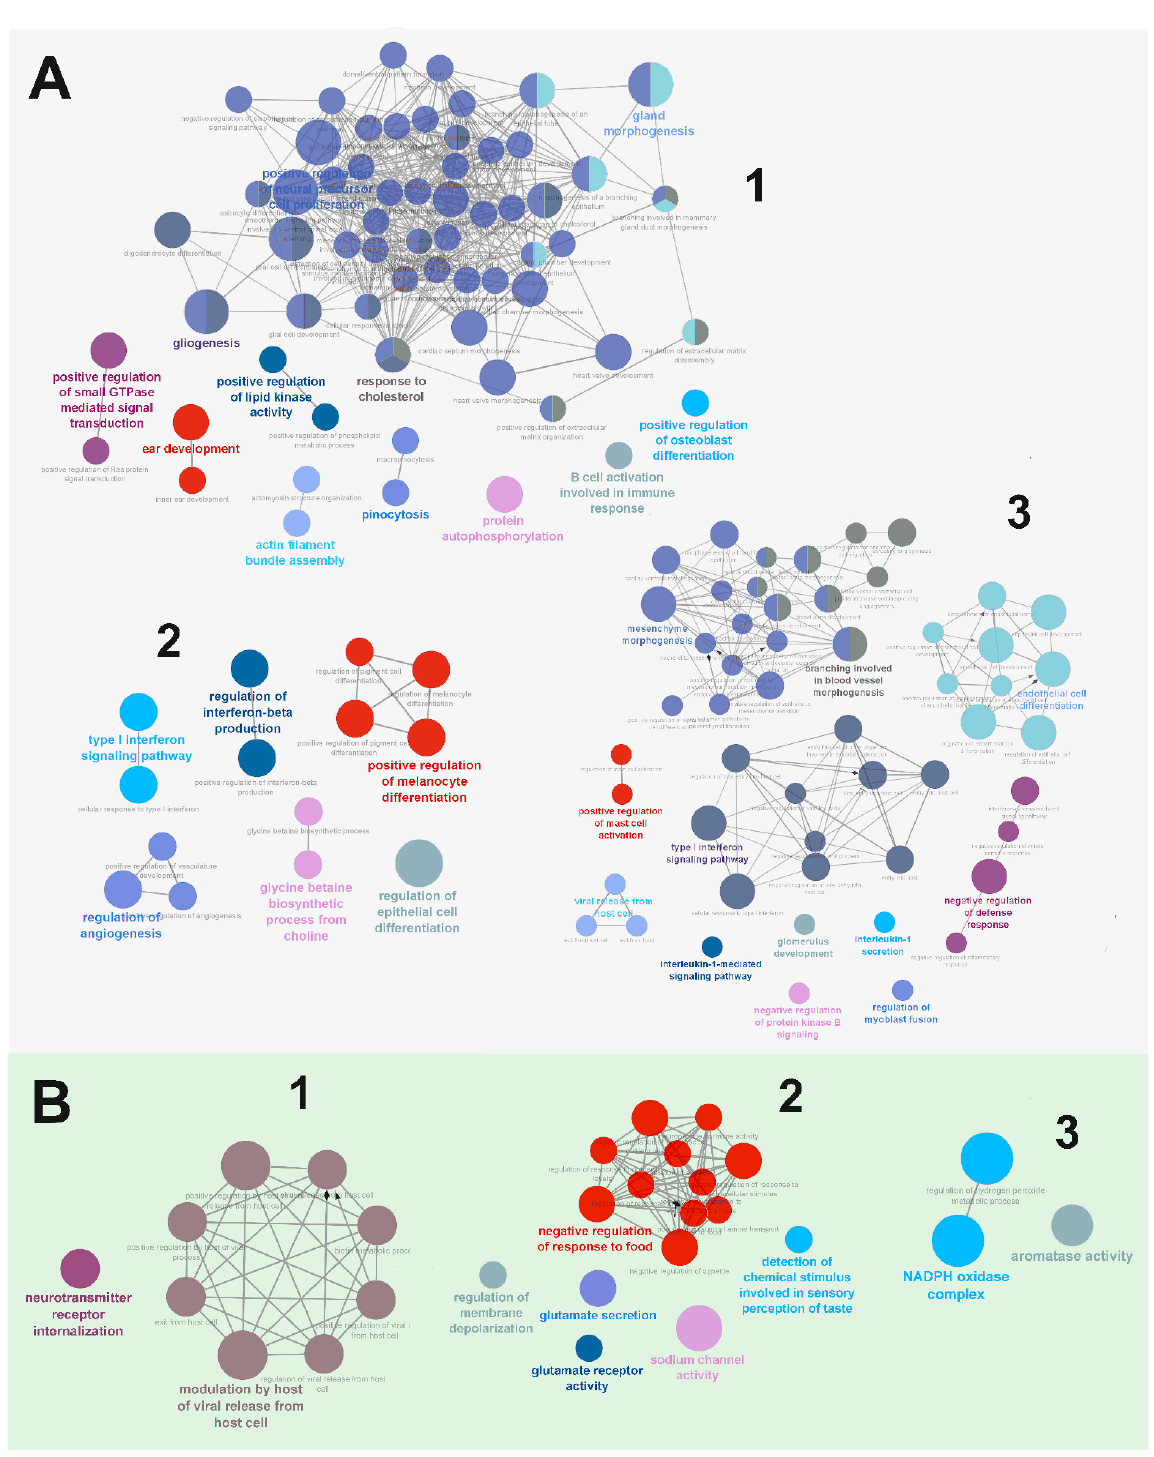
Figure 5. Co-expression network analysis and functional annotation of DEGs. Visualization of statistically overrepresented GO terms in a given set of genes from the three main co-expression network clusters (1–3) using the ClueGO plugin. Functional annotation of DEGs using ClueGO en- riched by downregulated ( A ) and upregulated DEGs ( B ). Each node refers to a specific Gene